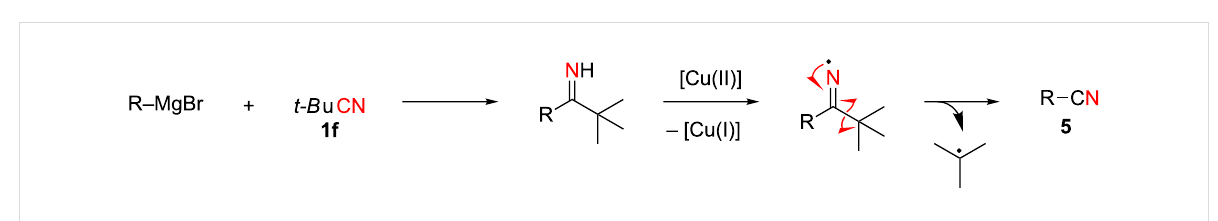
Scheme 6: Formation of bromoketone 6e